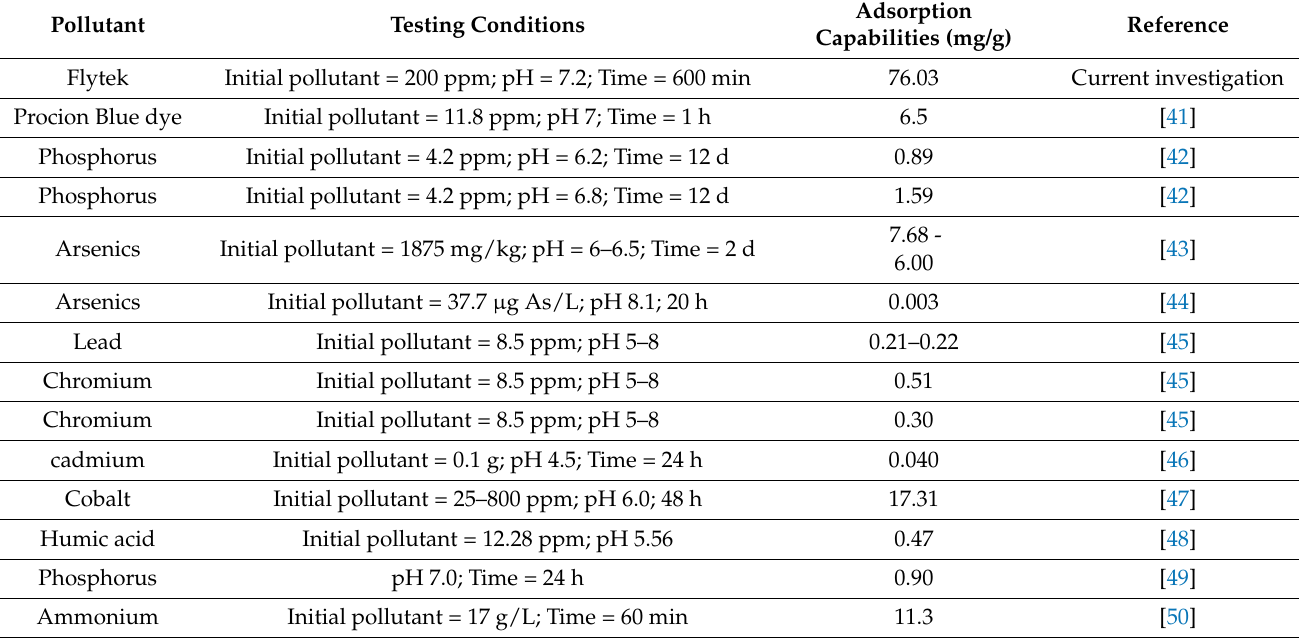
Table 4. Adsorption capabilities of numerous uptake removals from wastewater using AS